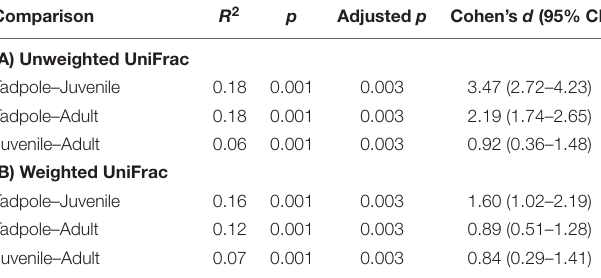
TABLE 3 | PERMANOVA pairwise comparisons of (A) Unweighted and (B) Weighted UniFrac distances between life stages.